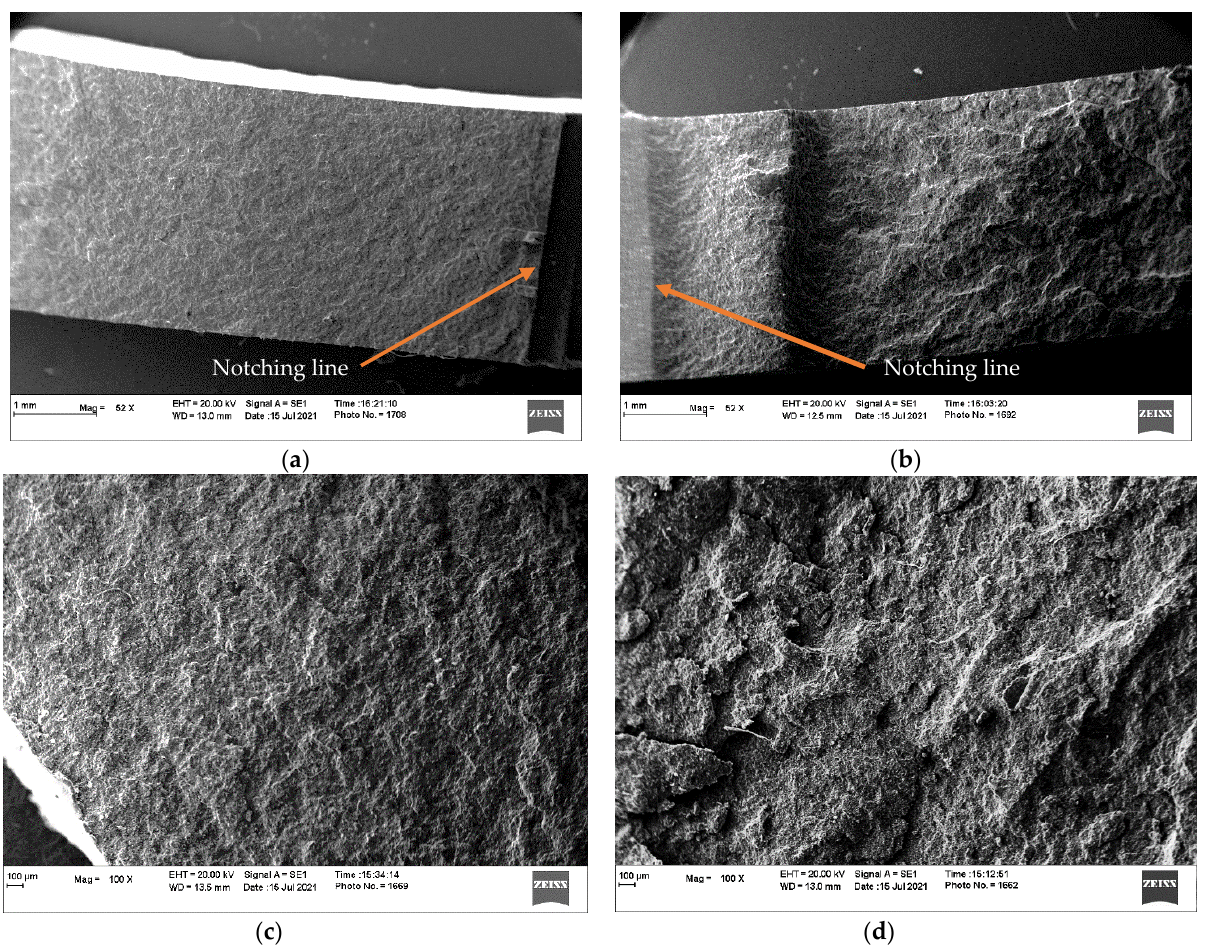
Figure 10. The comparison of the fracture surfaces for specimens after notched and unnotched impact tests: ( a , b ) notched and unnotched impact testing specimens for HPP filled with 30 wt.% CaCO 3 , ( c , d ) notched and unnotched impact testing specimens for HPP filled with 50 wt.% CaCO 3 .